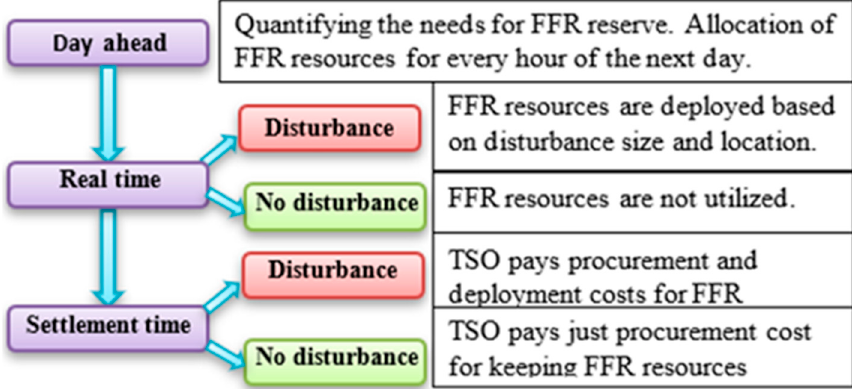
Figure 10. Timeline and cost associated with FFR service.